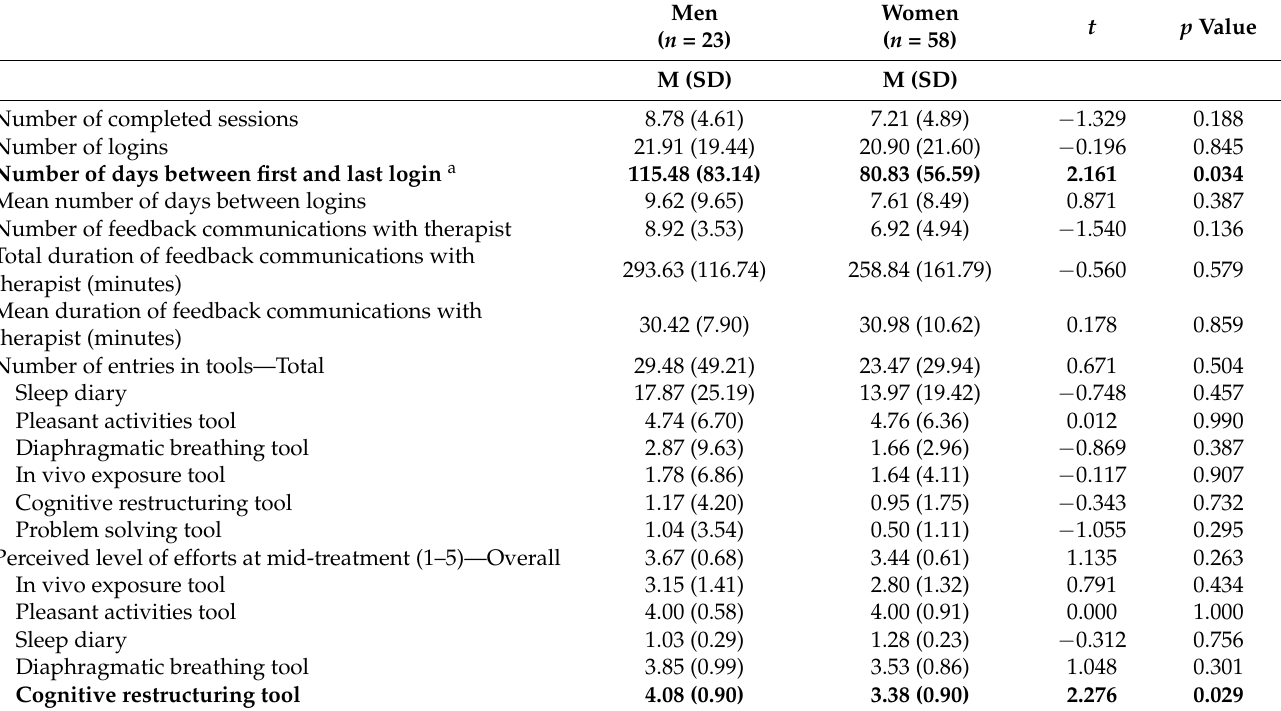
Table 3. Online treatment usage data for men and women ( N =